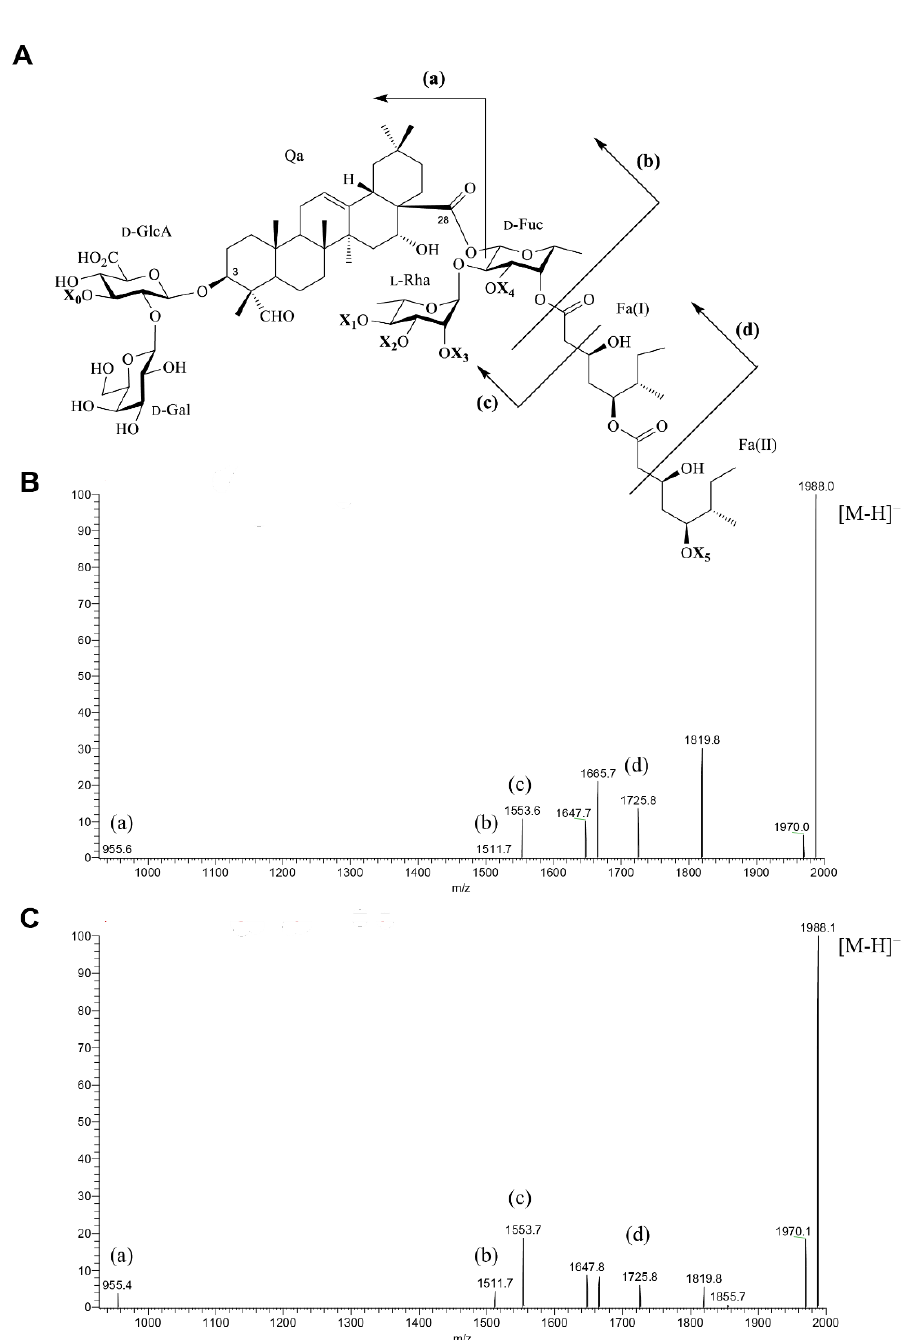
Figure 2. General structure of QS-21 and isomers ( A ). Negative mode MS 2 spectra of Qb1 and QS-21Xyl ( B , C , respectively) obtained from the precursor ion [M-H] − at m / z 1988.0 and 1988.1, respectively. The most relevant daughter ions are assigned in the generic structure shown in A. The X 0 and X 5 substituents correspond to pentose residues in both Qb1 and QS-21Xyl . Two additional pentose residues are substituting either the Rha or Fuc residues in both compounds, but their exact positions could not be determined solely by the MS 2 data (note that in this case all the possible substitution positions are indicated as X 1 – X 4 ).